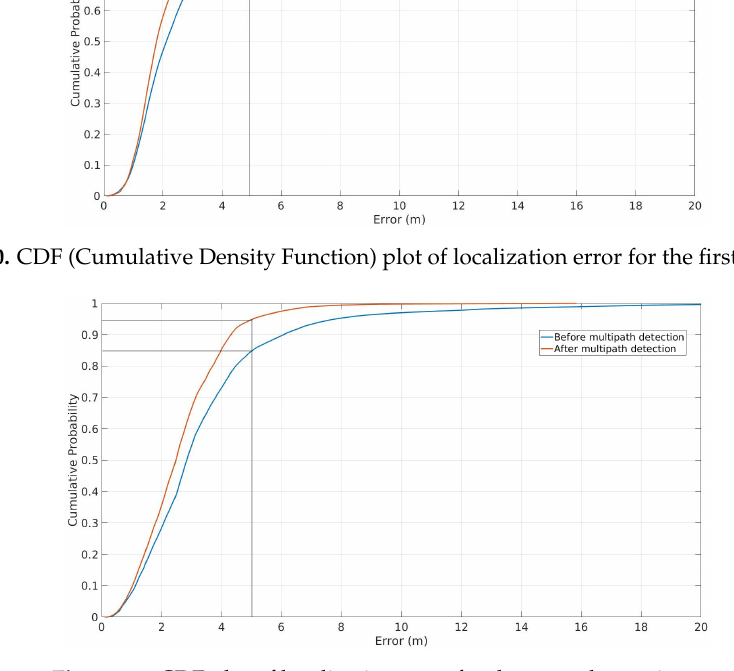
Figure 21. CDF plot of localization error for the second